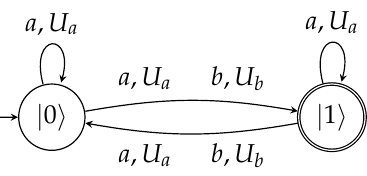
Figure 3. A simple quantum periodic automaton inspired from the work in [19]. The measurement period is µ = 5 (the period is equal to the sum 4 + 1 of the exponents), and it accepts with a probability of 1 the language ( a 4 b ) µ (or in case the input and the measurement mode is infinite, it accepts the ( a 4 b )